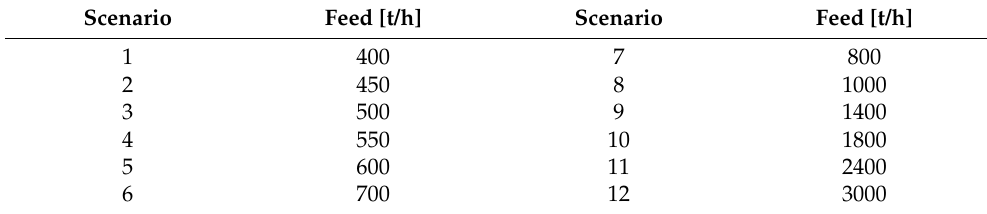
Table 2. Feed for every scenario